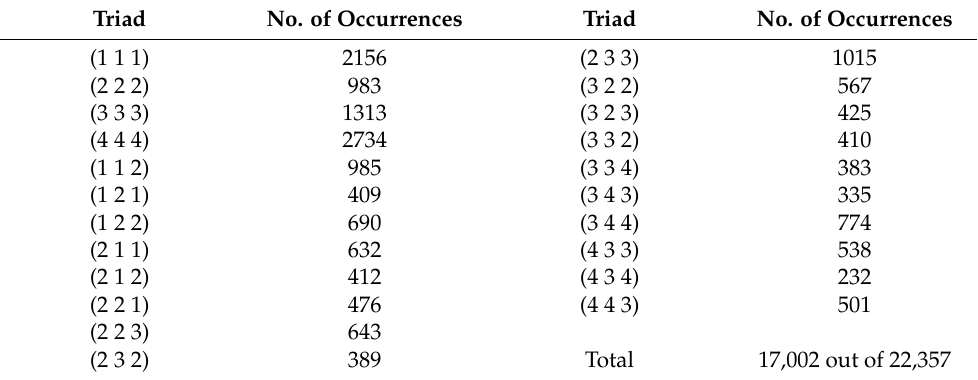
Table 4. Frequency of the triads with no or minor qualitative differences between reaction time deviations to